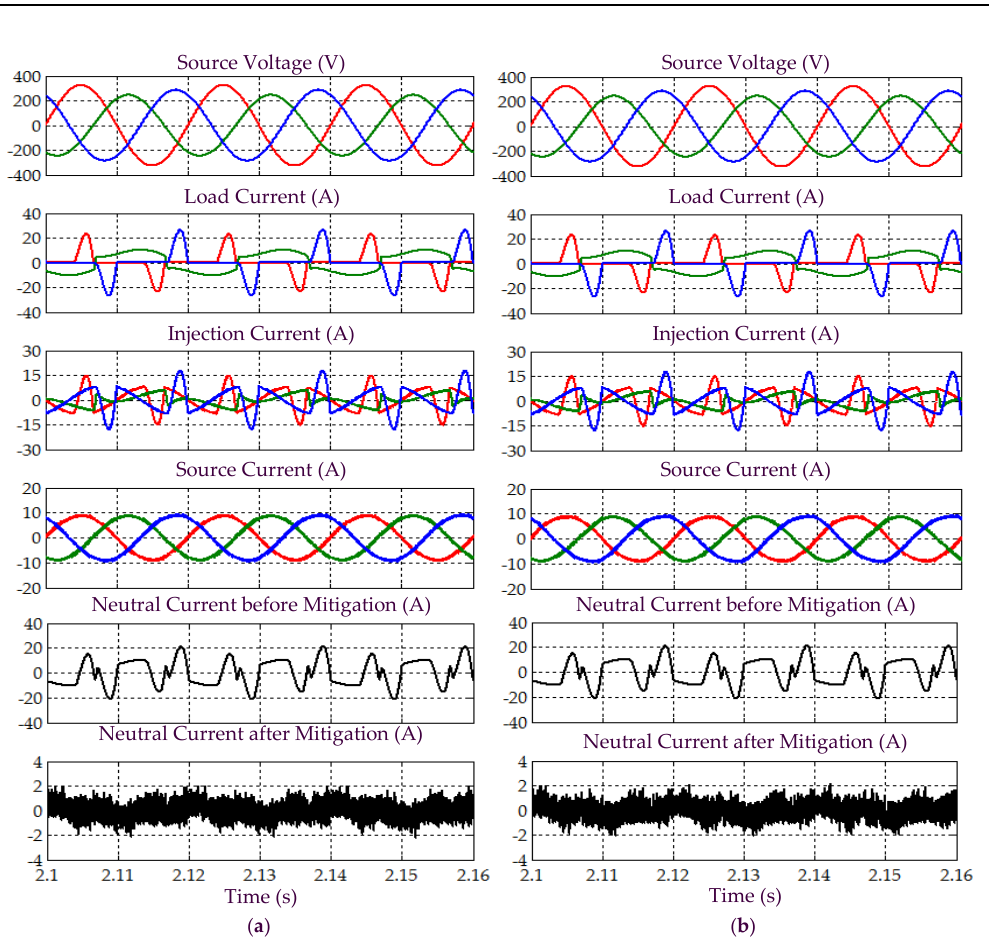
Figure 16. Simulation results obtained under Scenario C for Load 1, which include three-phase source voltage v Sabc , load current i Labc , injection current i injabc , source current i Sabc , and neutral current before and after mitigation, demonstrated by SAPF while applying the ( a ) proposed STF- dq 0 and ( b ) standard dq 0 techniques.